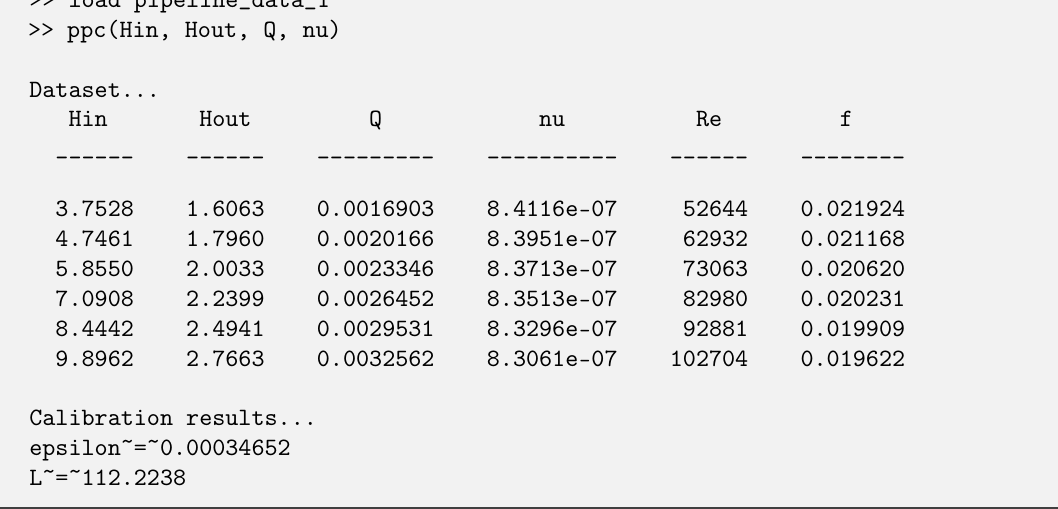
Figure 5. MATLAB output of the Pipeline Parameter Calibration (PPC) subroutine for the measurements in Table